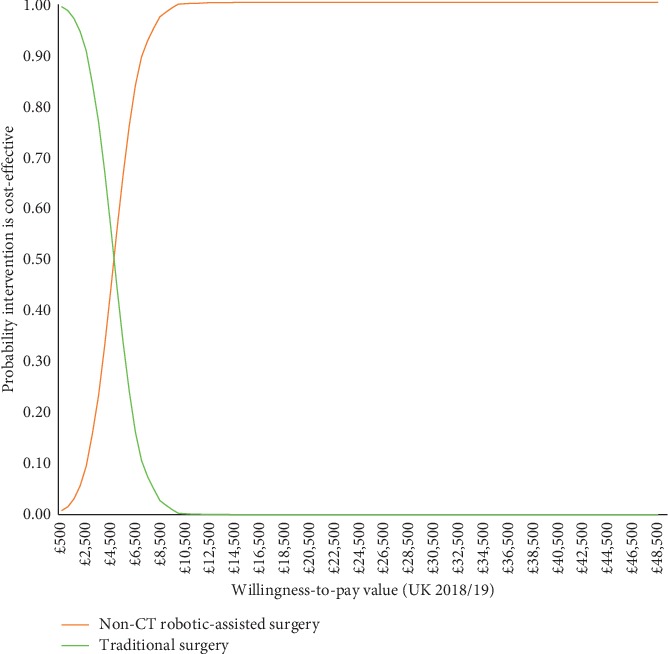
Cost-effectiveness acceptability curves.